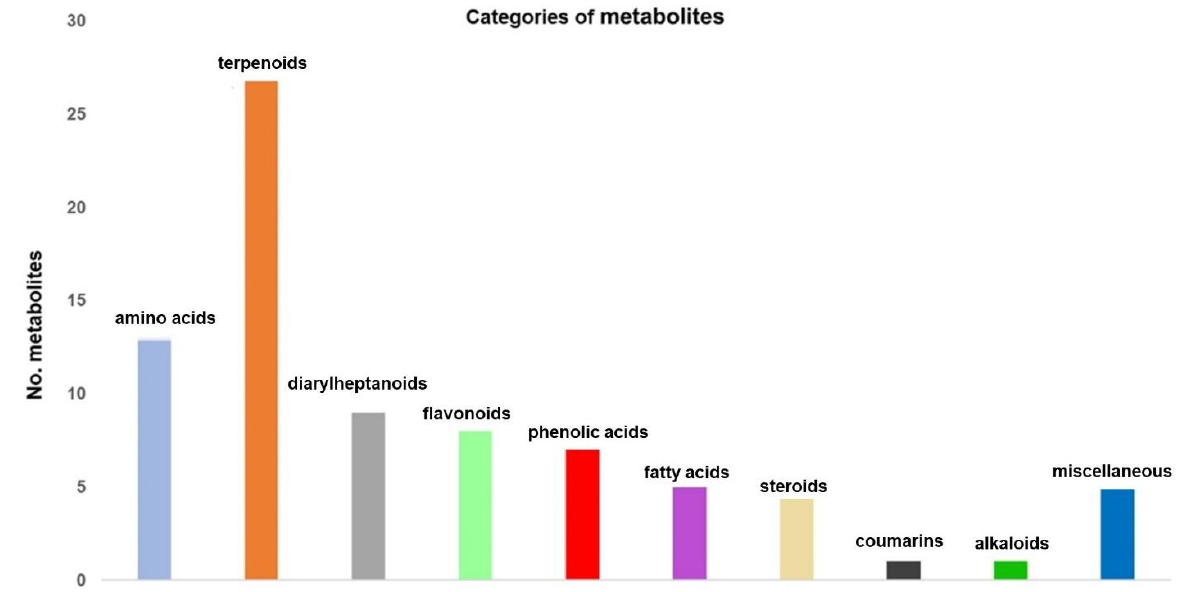
Figure 3. Metabolite classification bar chart of Curcuma longa . Amino acids and peptides : A total of 11 compounds were identified in the rhizome extract. The essential amino acids (valine, leucine, methionine, phenylalanine and arginine) represent about 45.45% of the total compounds. The non-essential amino acids (proline, aspartic acid, glutamic acid, cysteine, serine, glycine and alanine) represent a slightly higher proportion, accounting for about 54.55% of the total compounds [96–100]. About half of the amino acids identified in the curcuma rhizome sample (arginine, phenylalanine, glutamic acid, methionine, glycine, serine, aspartic acid and proline) act as antitumoral, neuroprotective, antiproliferative and immunomodulant agents [97–101]. Terpenoids and sesquiterpenes are the largest categories of phytoconstituents found in curcuma rhizome samples. Various studies have demonstrated their anti-inflammatory, antimicrobial, antioxidant, antiviral, antibacterial, antifungal, hepatoprotective, neuroprotective, analgesic and immune-modulation activities [74,89,96–104]. Diarylheptanoids ( curcuminoids ), another of the largest classes of bioactive compounds from curcuma, have been shown to exhibit anti-inflammatory, antioxidant, neuroprotective, antibacterial, antifungal, antitumor, hepatoprotective and antidiabetic activities [74,105–107]. Flavonoids are another class of metabolites identified in the curcuma sample. These bioactive phytoconstituents have remarkable pharmacological proprieties, including an- tioxidant, antitumoral, antimicrobial and anti-inflammatory activities, as well as effects against neurodegenerative diseases (Alzheimer’s disease)